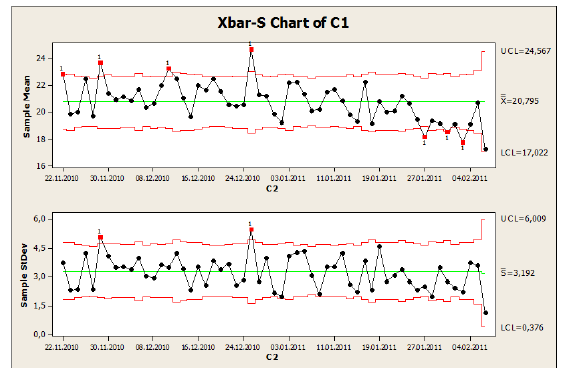
Fig. 6. Control chart for the travels times of the route starting from station EKP of the BRT line 34 to the interchange station of line M2.